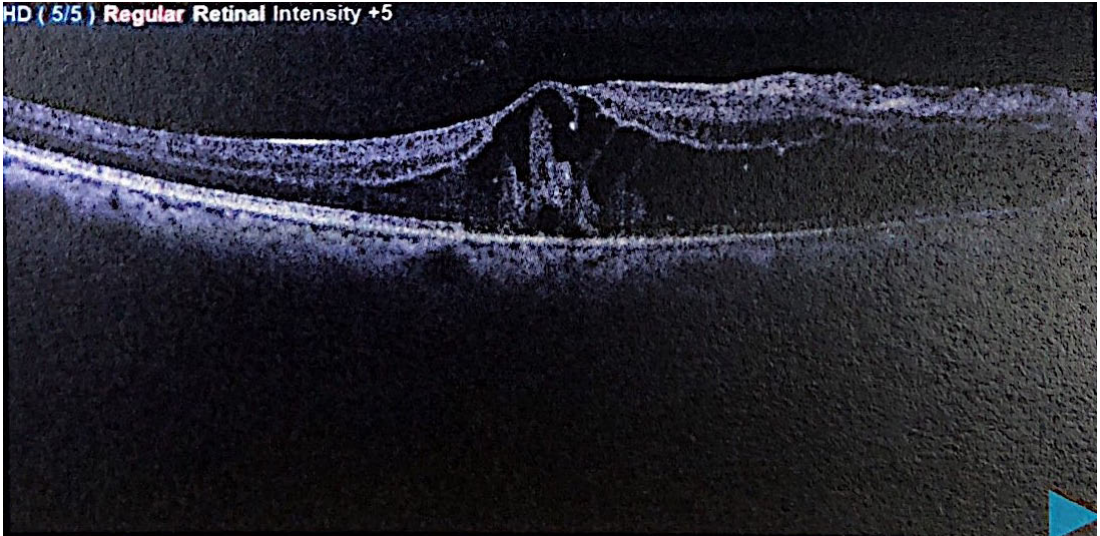
Figure 2: Right OCT: bilateral foveal serous detachment with CME and macular retinoschisis